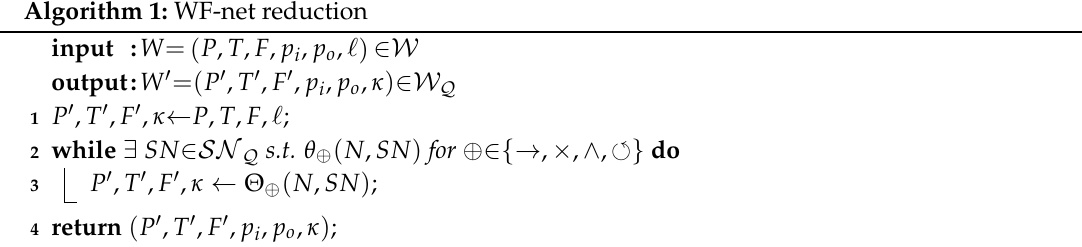
Algorithm 1: WF-net